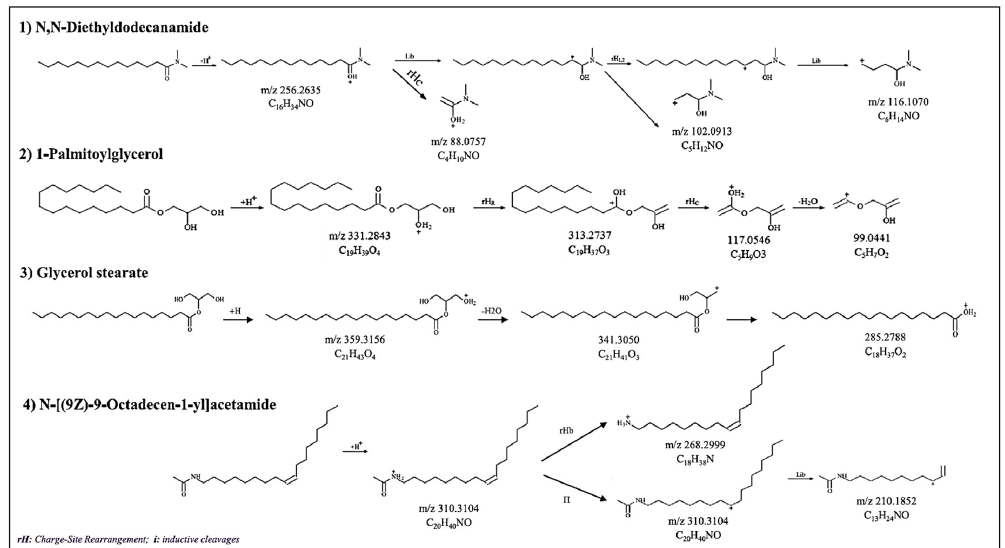
Figure 3. Tentative proposal fragmentation mechanism for the compounds detected by LC-Q- Orbitrap-MS. Reprinted with permission from ref. [35].